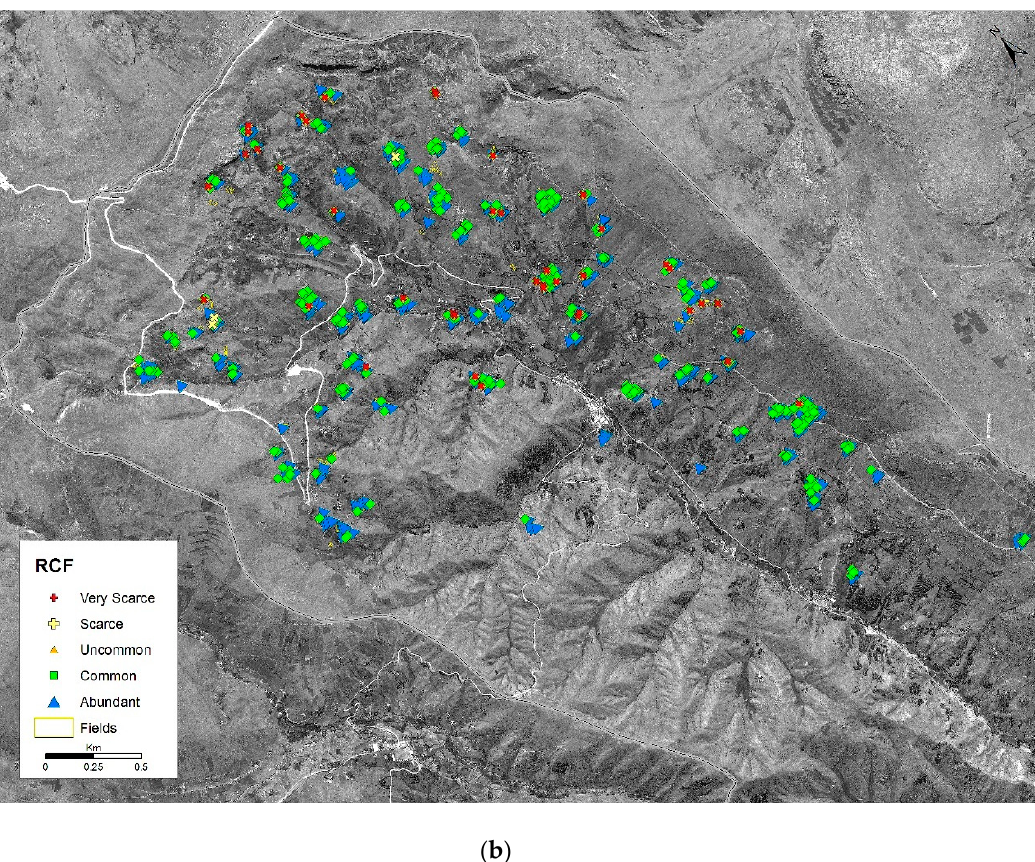
Figure 2. ( a ) Spatial distribution of total unique cultivars sampled based on their relative cultivar frequency (RCF) index values (RCF < 0.05 = very scarce, RCF < 0.10 = scarce, RCF < 0.25 = uncommon, RCF < 1.00 = common, 188 RCF > 1.00 = abundant) in the community of Bellavista, Pasco; ( b ) Spatial distribution of total unique cultivars sampled based on their relative cultivar frequency (RCF) index values (RCF < 0.05 = very scarce, RCF < 0.10 = scarce, RCF < 0.25 = uncommon, RCF < 1.00 = common, 188 RCF > 1.00 = abundant) in the community of Huachhua, Huancavelica.